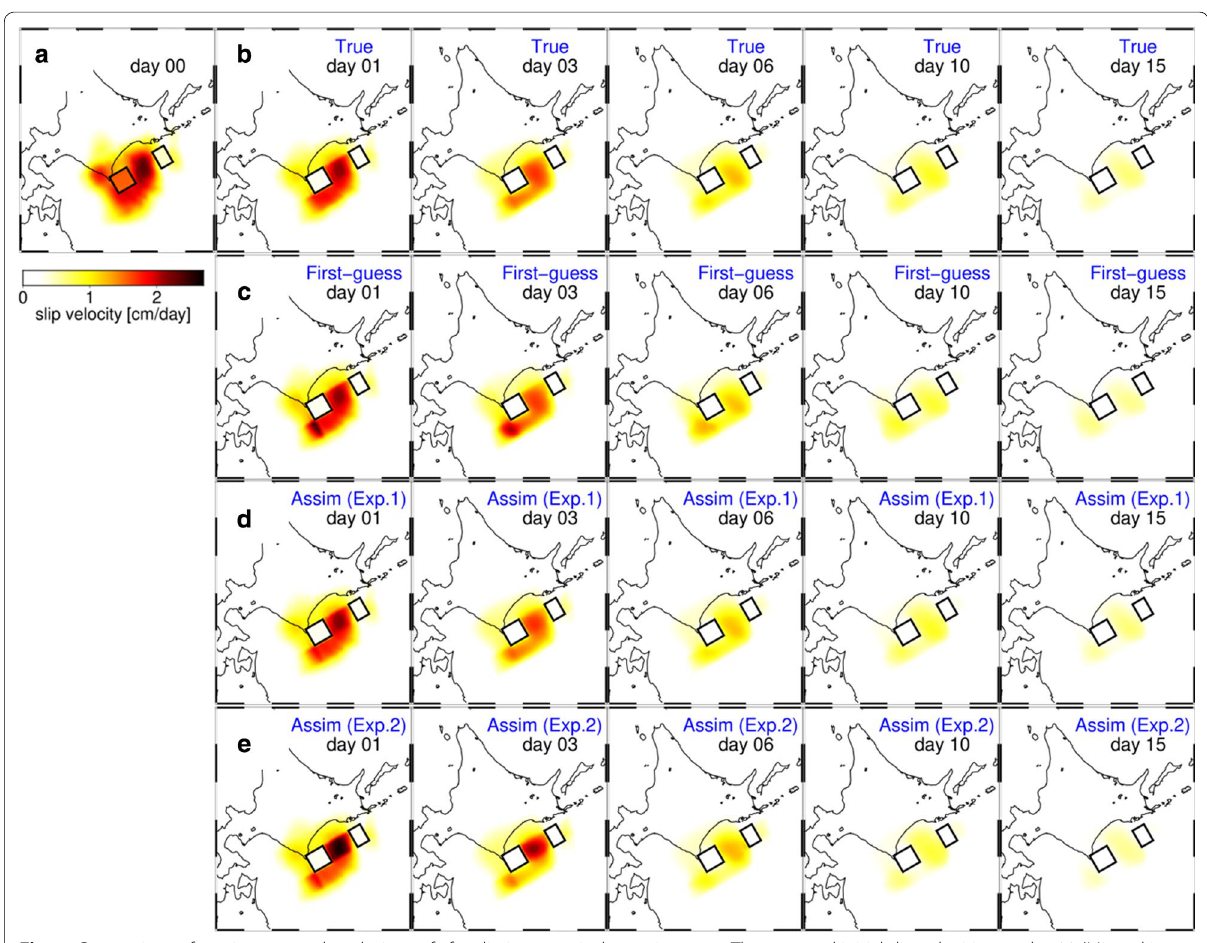
Fig. 7 Comparison of spatio-temporal evolutions of afterslip in numerical experiments. a The assumed initial slip velocities on day 00 (Miyazaki et al. 2004). b – e Temporal evolutions of afterslip calculated by using b the true, c the first-guess, and the optimum frictional parameters in d Exp. 1 and e Exp.